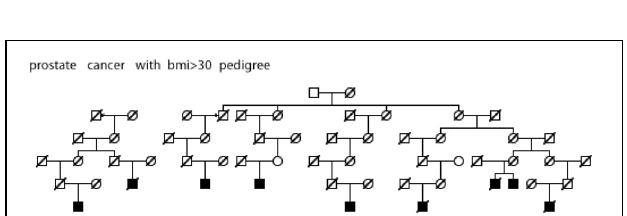
FIGURE 5 | High risk Utah prostate cancer pedigree (56 prostate cancer cases observed among descendants of the pedigree founder, 36 expected, p = 0 . 001); cases with BMI ≥ 30 are shown.